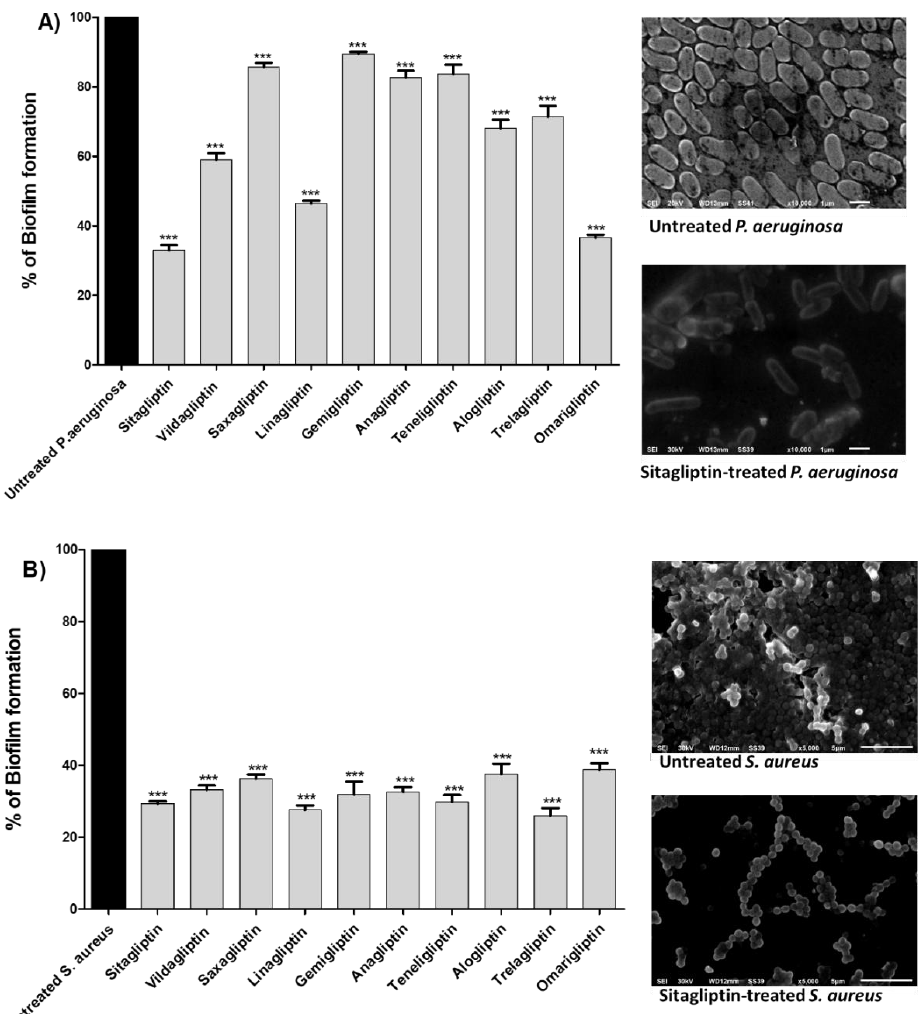
Figure 2. Antibiofilm activities of the tested gliptins. The crystal violet method was employed to stain the biofilm-forming cells in the absence or presence of gliptins at sub-MICs. The absorbances of the crystal-violet-stained biofilm-forming cells were measured at 590 nm in the absence or presence of gliptins at sub-MICs. The experiment was performed in triplicate, and the results are expressed as the percentage change from the untreated bacterial control. Data are presented as mean ± SD, and two-way ANOVA test followed by Bonferroni post-test was employed to test significance. Gliptins significantly diminished ( A ) P. aeruginosa or ( B ) S. aureus biofilm formation. Furthermore, representative electron microscope images were captured to show the effect of sitagliptin at sub-MIC on the formation of biofilm. Sitagliptin obviously inhibited both P. aeruginosa and S. aureus biofilms. ***: p ≤ 0.001.